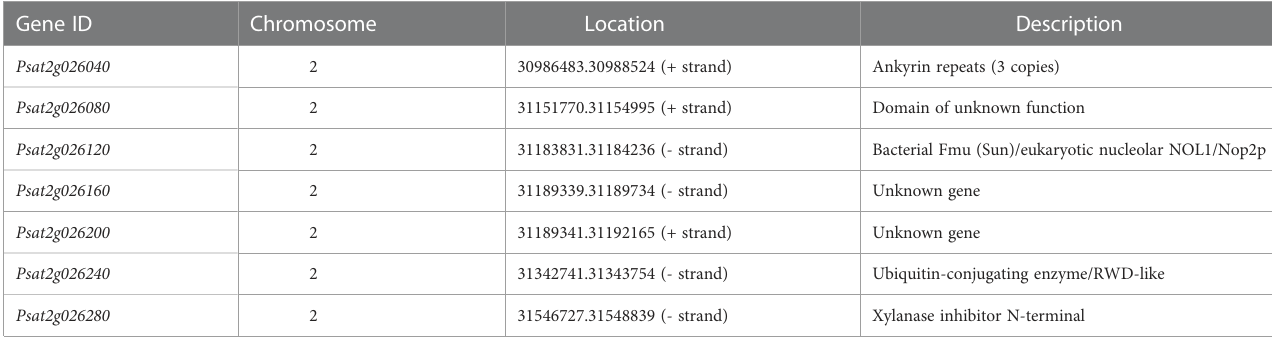
TABLE 2 Annotated genes in mapping region of qPsBr2.1